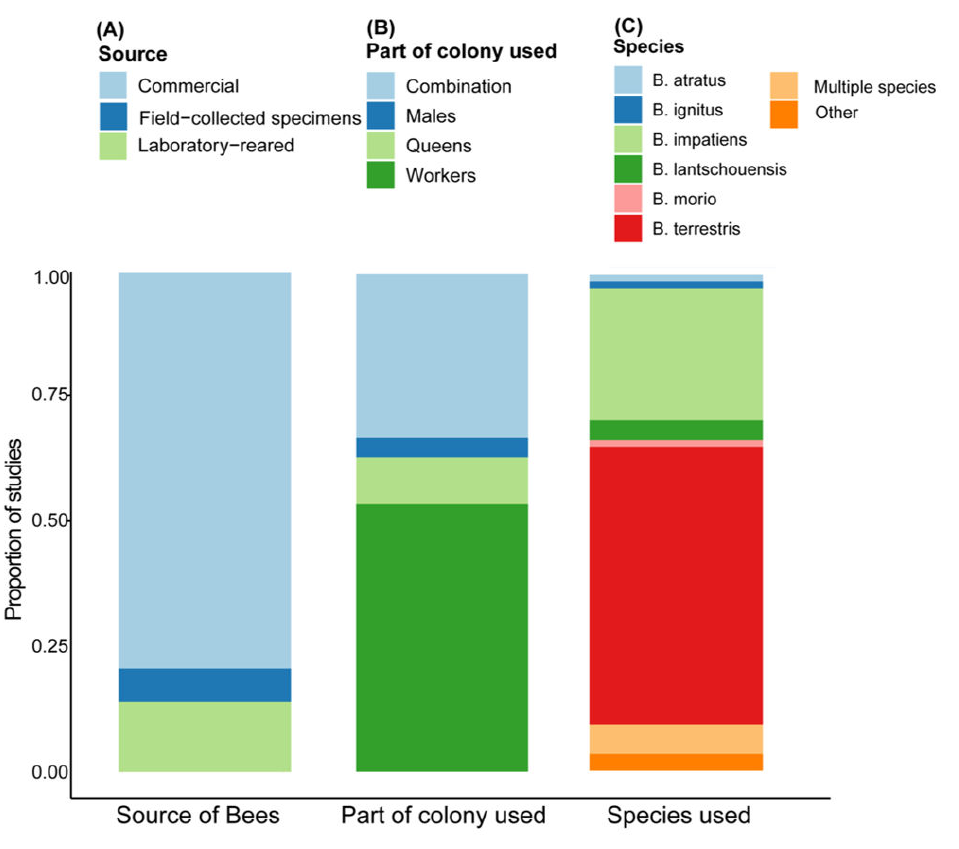
Figure 1. A literature review of the common uses of bumble bees in research studies. We